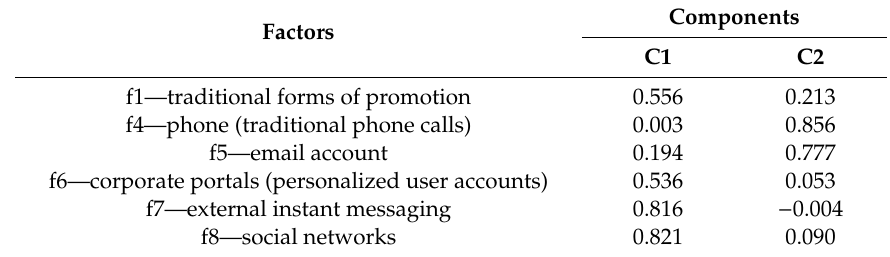
Table 12. Matrix of rotated components for factors of the complexity of communication with customers. Components Factors C1 C2 f1—traditional forms of promotion 0.556 0.213 f4—phone (traditional phone calls) 0.003 0.856 0.194